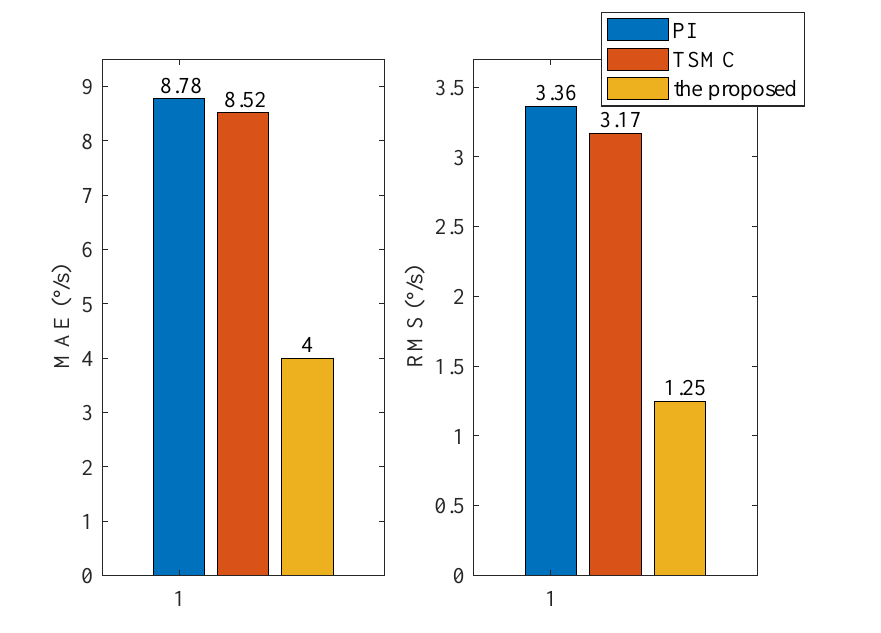
Figure 13. Experimental response curves under Case I.